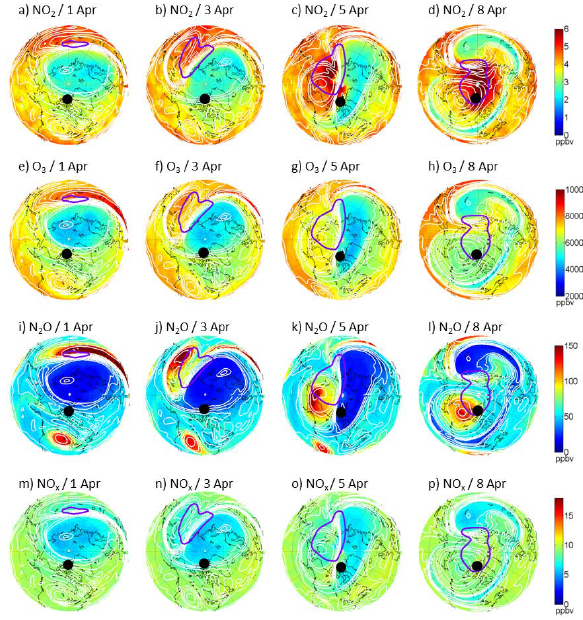
Fig. 5. Polar maps at the 600-K ( ∼ 23-km) potential temperature of GMI NO 2 (top row), ozone (top middle row), N 2 O (bottom mid- dle row), and NO x (bottom row) VMRs given in ppbv for 1, 3, 5 and 8 April 2011. Low [high] VMRs are given in blue [red]. White lines indicate PV contours. The area enclosed by the purple contour indicates T > 235K. Eureka is indicated by the black circle.